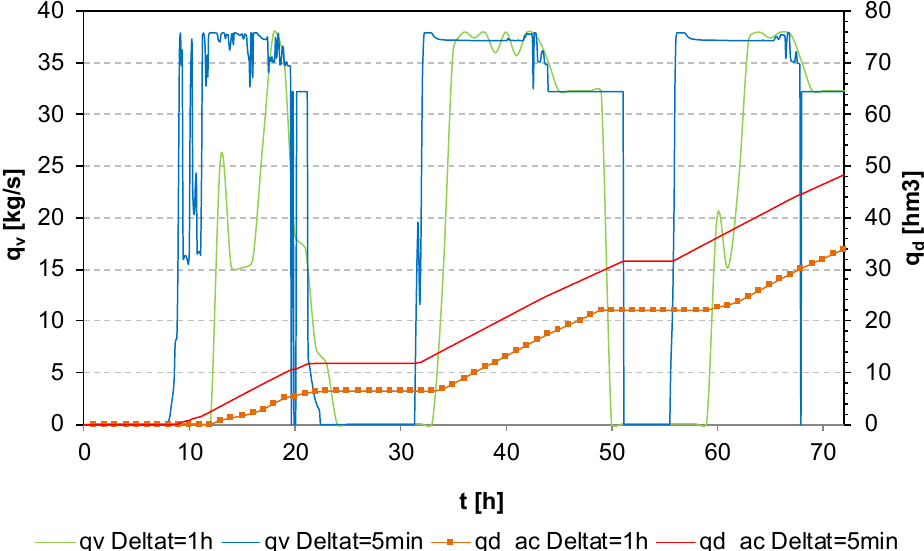
Figure 8. Simulation results for the freshwater mass flow rate ( q v ) and freshwater volume ( q d ) for three days in summer, 21–23 June, with 5 min and 1 h time steps.